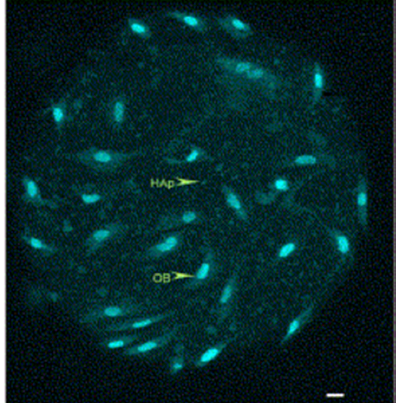
Figure 5. Confocal microscopy of osteoblast cells cultured on microsphere staining with DNA dye YOYO-1 (HAp: hydroxyapatite, OB: osteoblast; 4 days after seeding). Reprinted from [47] with permission from Elsevier.